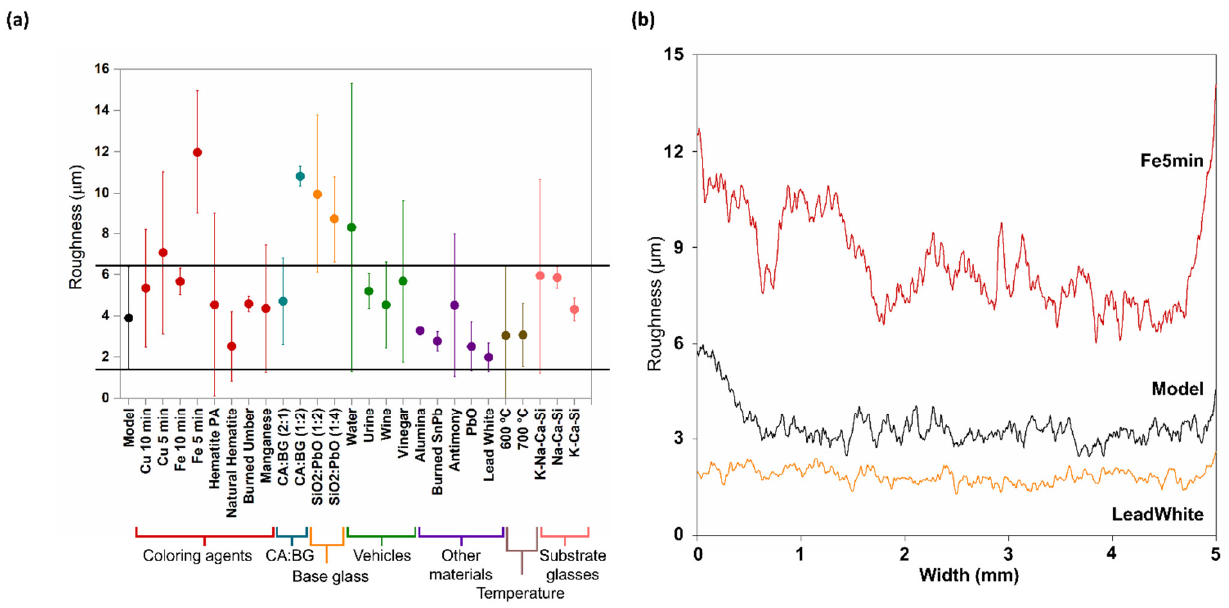
Figure 3. Results from the roughness analysis, ( a ) graphical representation from the average rough- ness (Ra*) and their standard deviations of the produced grisaille samples, ( b ) graphical representation of the roughness variation throughout the sample length.